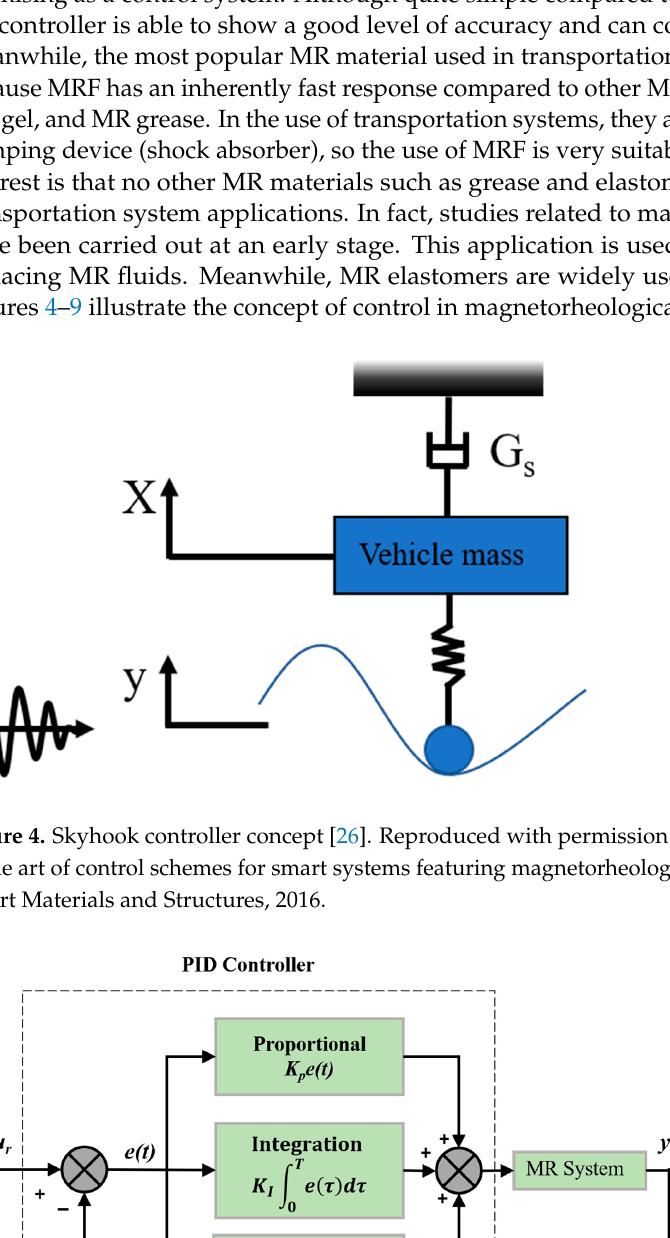
Figure 6. Block diagram of ( a ) LQG and ( b ) LQR [26]. Reproduced with permission from Choi, S. ‐ B. et al. State of the art of control schemes for smart systems featuring magnetorheological materi ‐ als; published by Smart Materials and Structures, 2016. Figure 7. Sliding mode controller block diagram [26]. Reproduced with permission from Choi, S. ‐ B. et al. State of the art of control schemes for smart systems featuring magnetorheological materi ‐ als; published by Smart Materials and Structures, 2016.